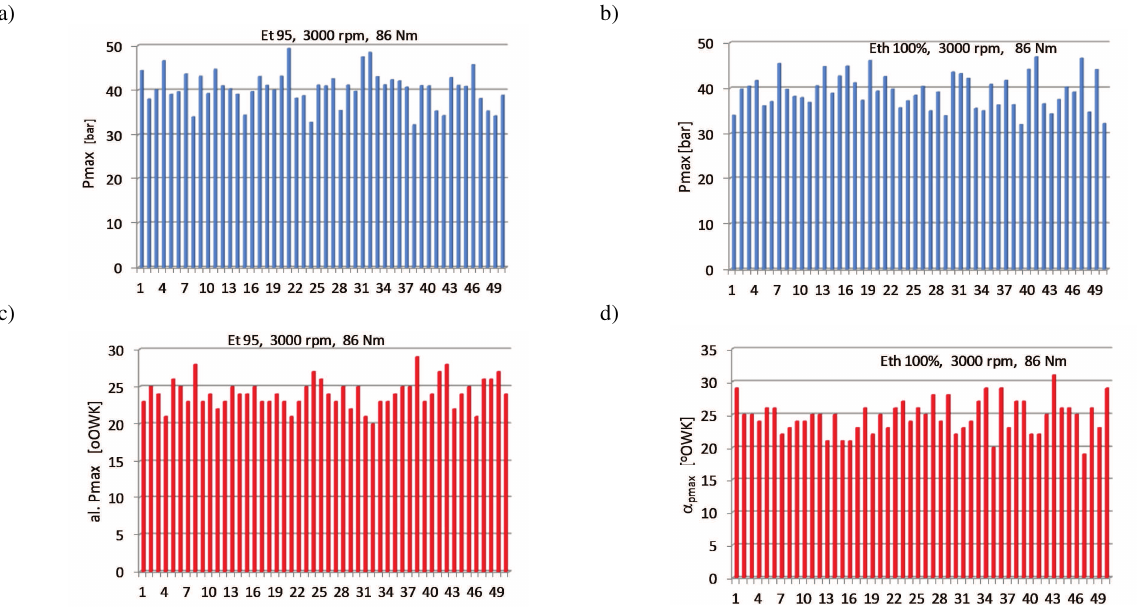
Fig. 4. Comparison of maximal combustion pressures and angles of their occurrence in the Fiat 1100 MPI engine fueled with Et 95 gasoline and Eth 100% alcohol